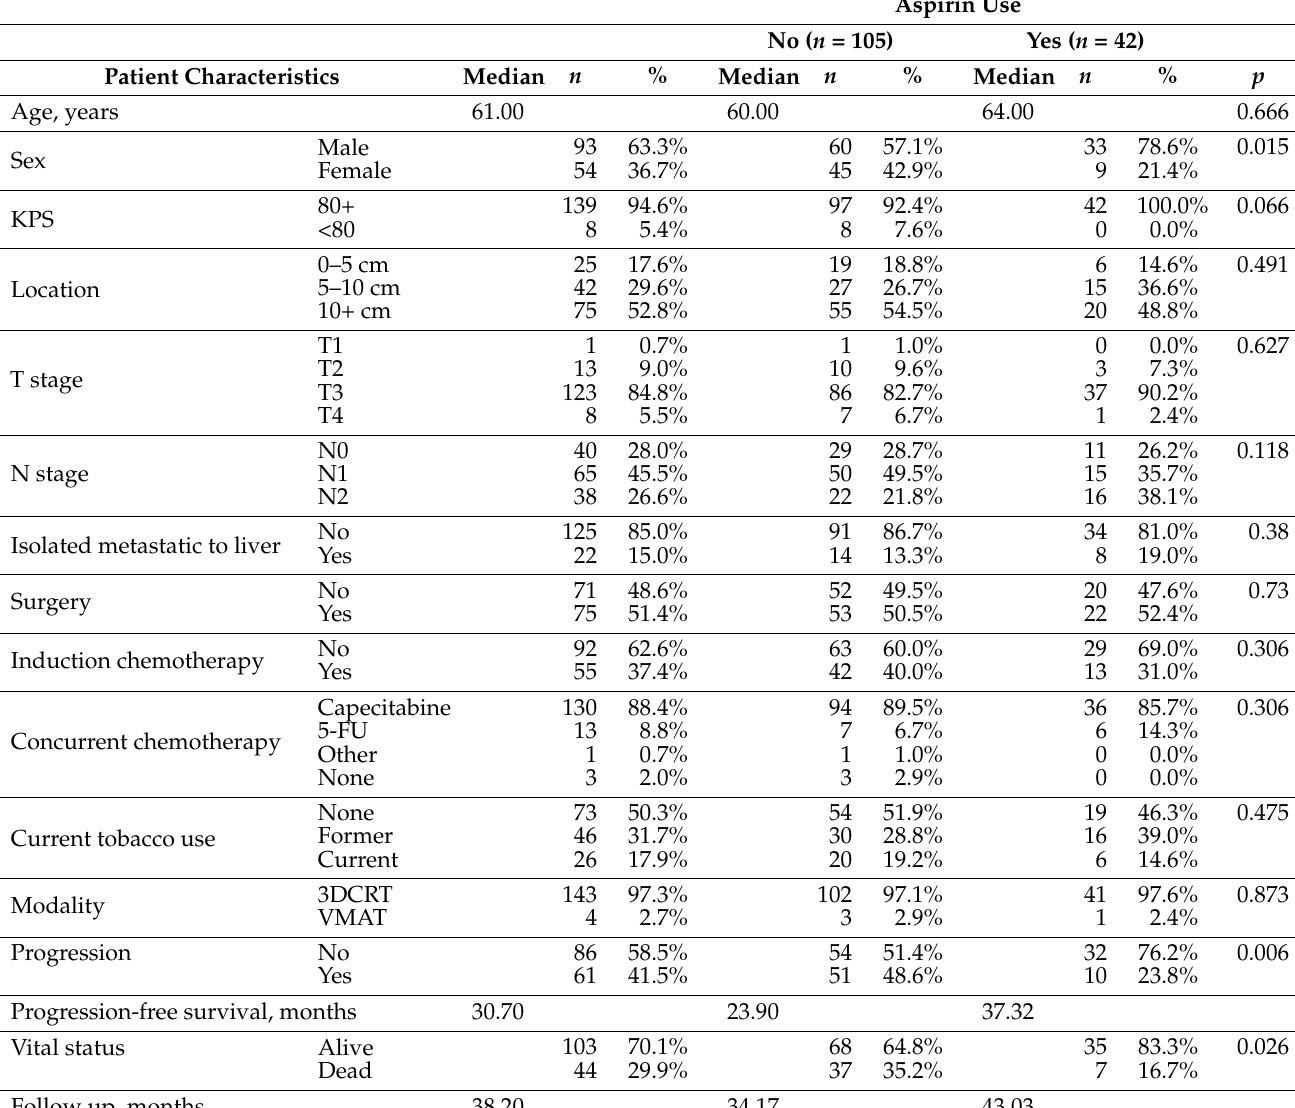
Table 1. Patient